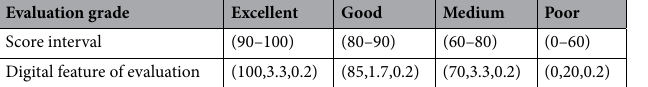
Table 9. Standard Review Cloud Model.